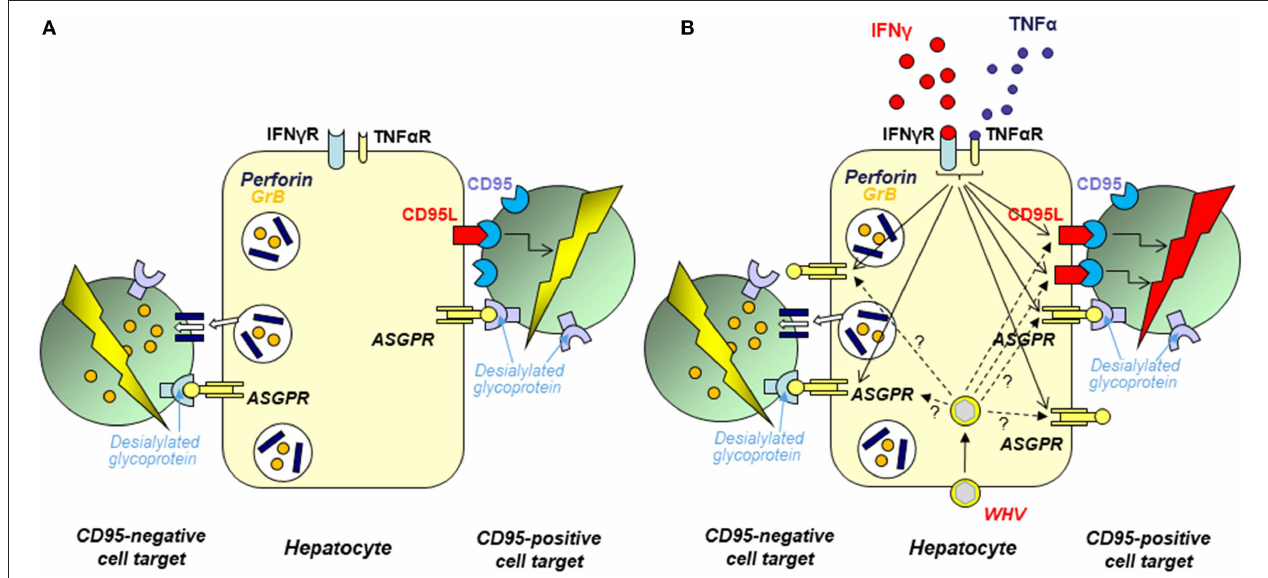
FIGURE 6 | Schematic presentation of the mechanisms and factors affecting elimination of cells brought to contact with hepatocyte surface. In opposite to the previous opinion, hepatocytes intrinsically transcribe perforin, as well as CD95 and CD95 ligand (CD95L) and can utilize both perforin-granzyme B (GrB) and CD95L-CD95 pathways to kill other cells. The acquired experimental data indicate that hepatocytes can recognize other cells via interaction between desialylated glycoproteins on the target cell surface and asialoglycoprotein receptor (ASGPR) on hepatocyte plasma membrane. (A) Normal hepatocytes show ability to eliminate contacted cells by both CD95L- and perforin-dependent mechanisms. ASGPR involvement in this process is supported by demonstration that desialylation of surface glycoproteins on target cells enhanced their susceptibility to hepatocyte-mediated killing and that inhibition of hepatocyte ASGPR by asilofetuin, a ASGPR-specific ligand, or by silencing of ASGPR gene by specific siRNA significantly limited hepatocyte-facilitated cell killing. (B) The hepatocyte capacity to eliminate cells brought to contact with their surface is augmented after hepatocyte exposure to IFN- γ or TNF- α . This appears to be a consequence of the combined effects of enhanced expression of the cytotoxic effector molecules and augmented display of ASGPR on hepatocyte surface (indicated by arrows with continuous stamps). In chronic WHV hepatitis and resolved acute WHV infection, hepatocyte CD95L- and perforin-dependent cytotoxicity is augmented when compared to hepatocytes from livers of healthy woodchucks. This appears to be a consequence of liver inflammation caused by WHV which progression and resolution are associated with augmented production of many bioactive factors including IFN- γ and TNF- α . It also is possible that the augmented hepatocyte cytotoxicity in some situations could be due to a direct effect of virus (WHx protein) via upregulated expression of the cytotoxic effector molecules or ASGPR in hepatocytes (marked by arrows with dashed stamps). For details see Guy et al. ( 149–151), Guy et al.